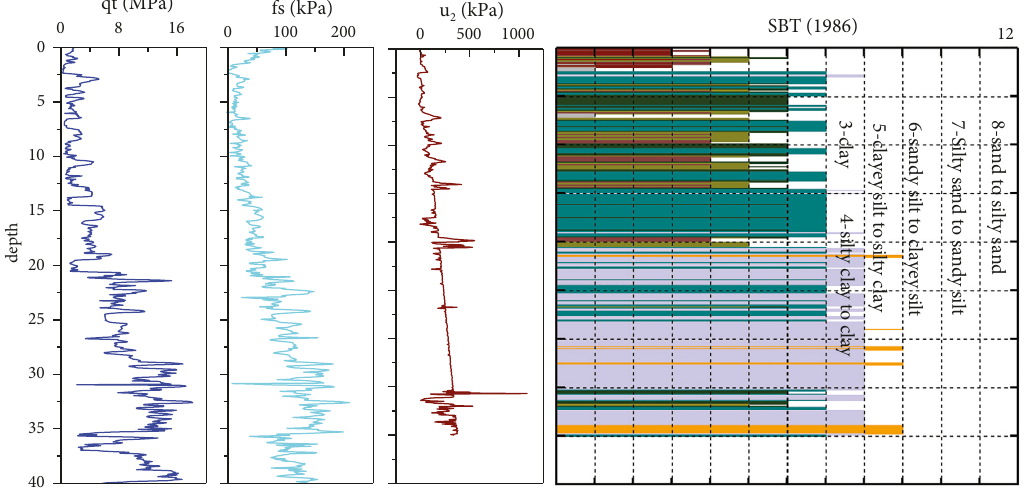
Figure 5: Typical results showing soil types of N01 at Site